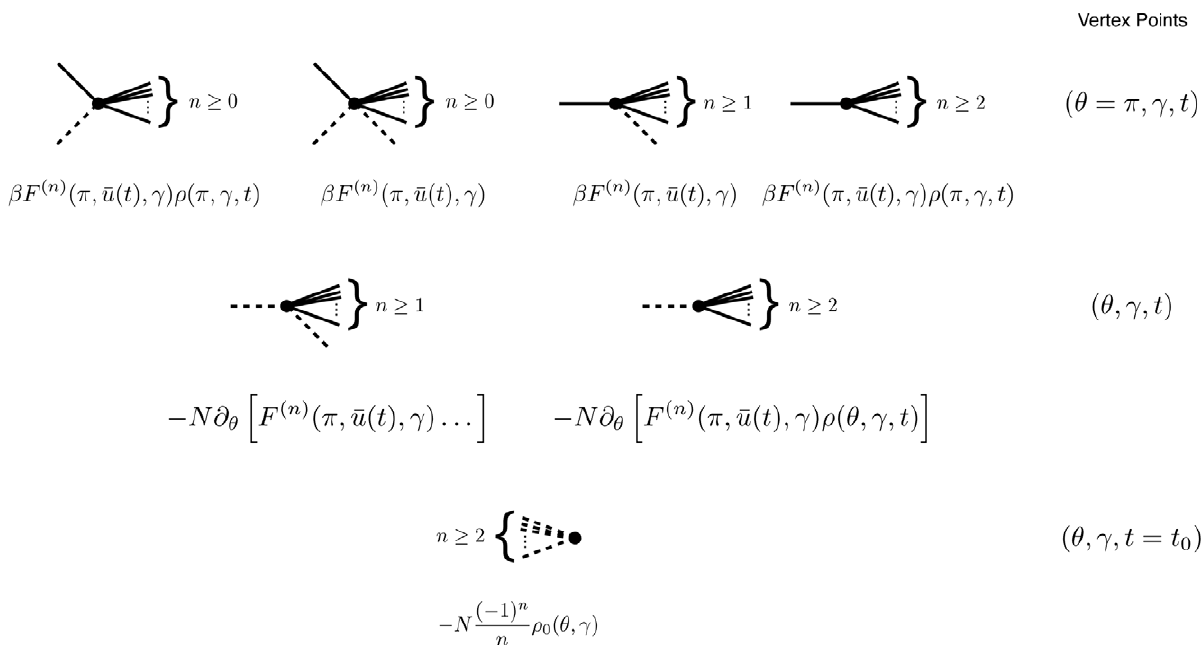
Figure 4. Vertices of the Feynman Rules for the neural models. F ( n ) indicated the n th derivative of F with respect to u . ‘‘Vertex Points’’ refers to the arguments at which vertex operators are evaluated. Those arguments that are not fixed (e.g. h ~ p ) are integrated over. The first row is derived from S u , the second and third from S y . The last row represents the initial state terms.